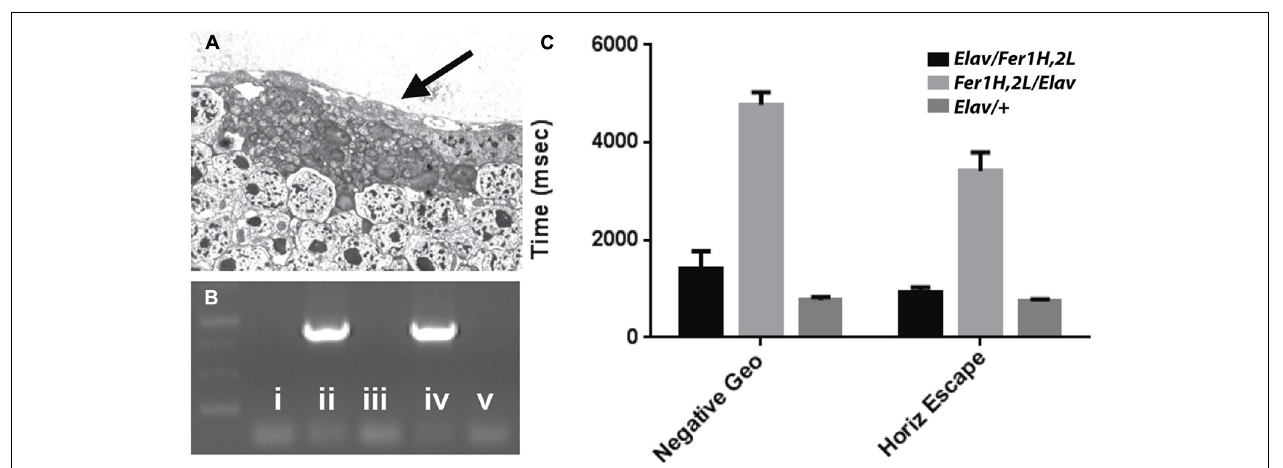
FIGURE 3 | Lifespan determinations of cohorts of female adult D. melanogaster. Day 0 marks eclosion, flies were kept with the opposite sex for the first five days, then they were separated on groups of 20 and transferred to fresh food regularly. (A) The same genotypes assayed in Figure 1 for behavior were used here.The experiments were performed three times independently (each time with a minimum cohort of 120 flies per genotype) and standard deviations are shown between the three